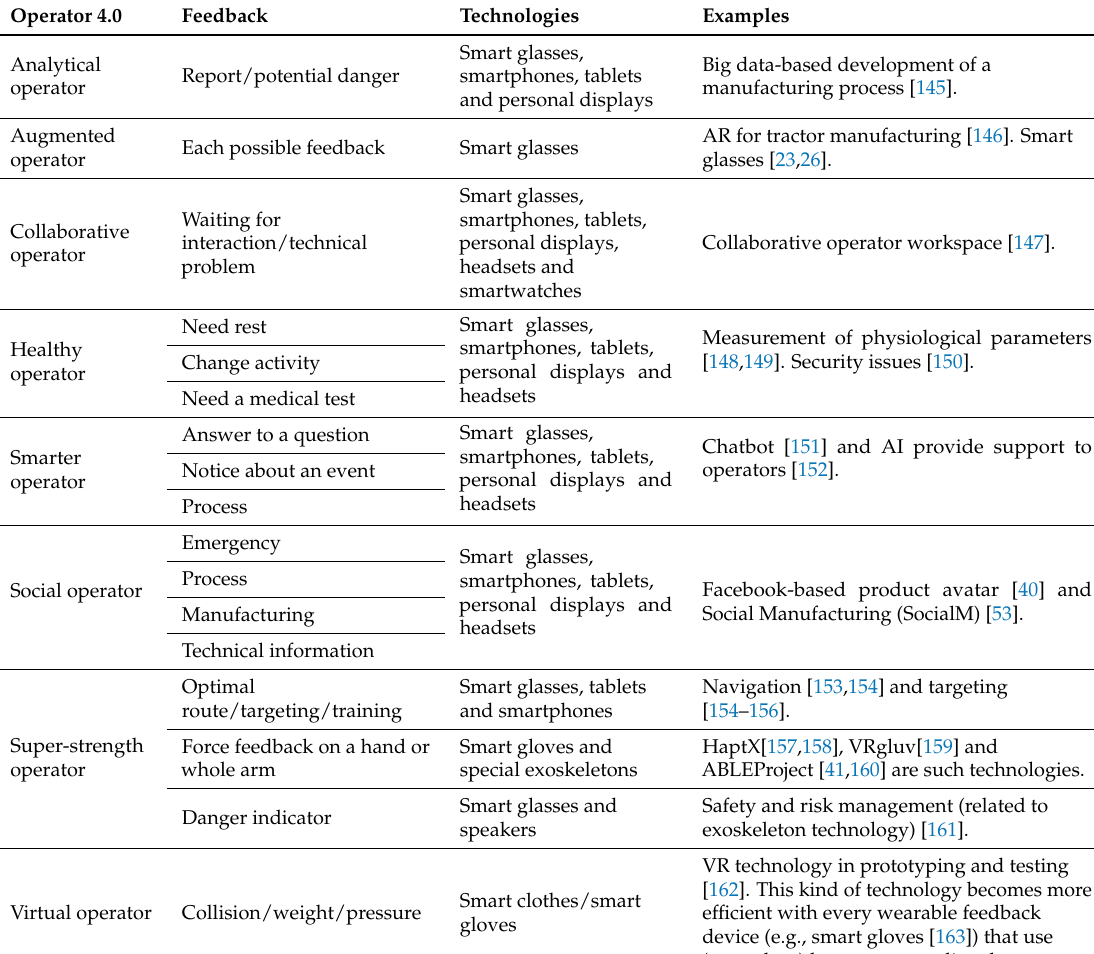
Table 6. Feedback technologies for Operator 4.0